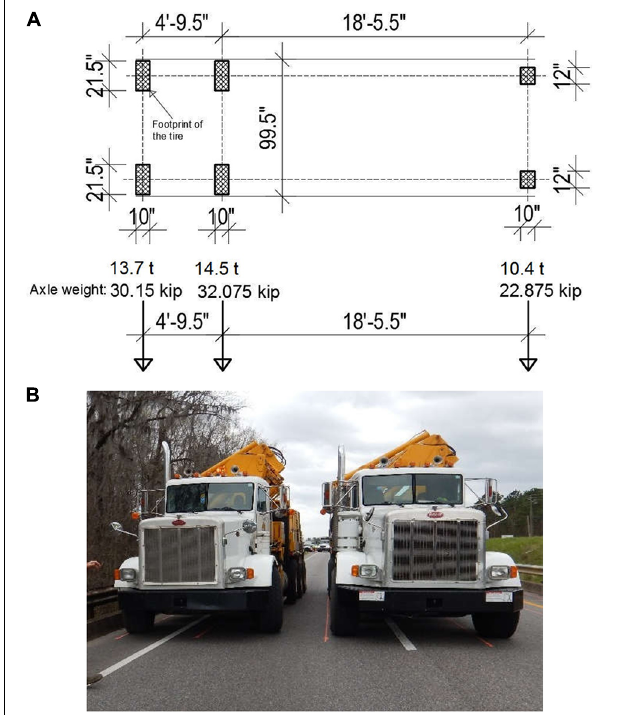
FIGURE 5 | (A) Load configuration and axle spacing for ALDOT’s Load Case LC-5, (B) example load pattern